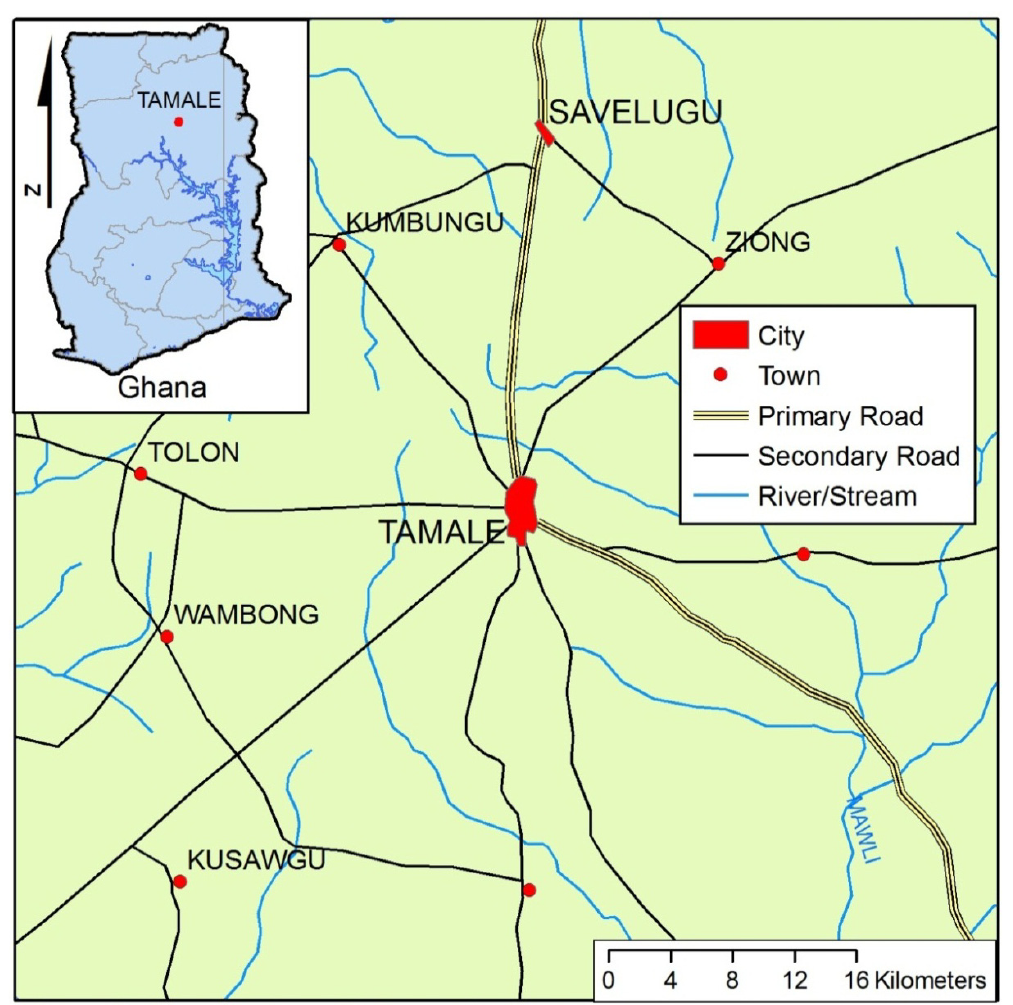
Figure 2 . Map a (1:500,000) indicating the location for the Randomized Controlled Trial of the Plastic Biosand Filter in Tamale, Ghana